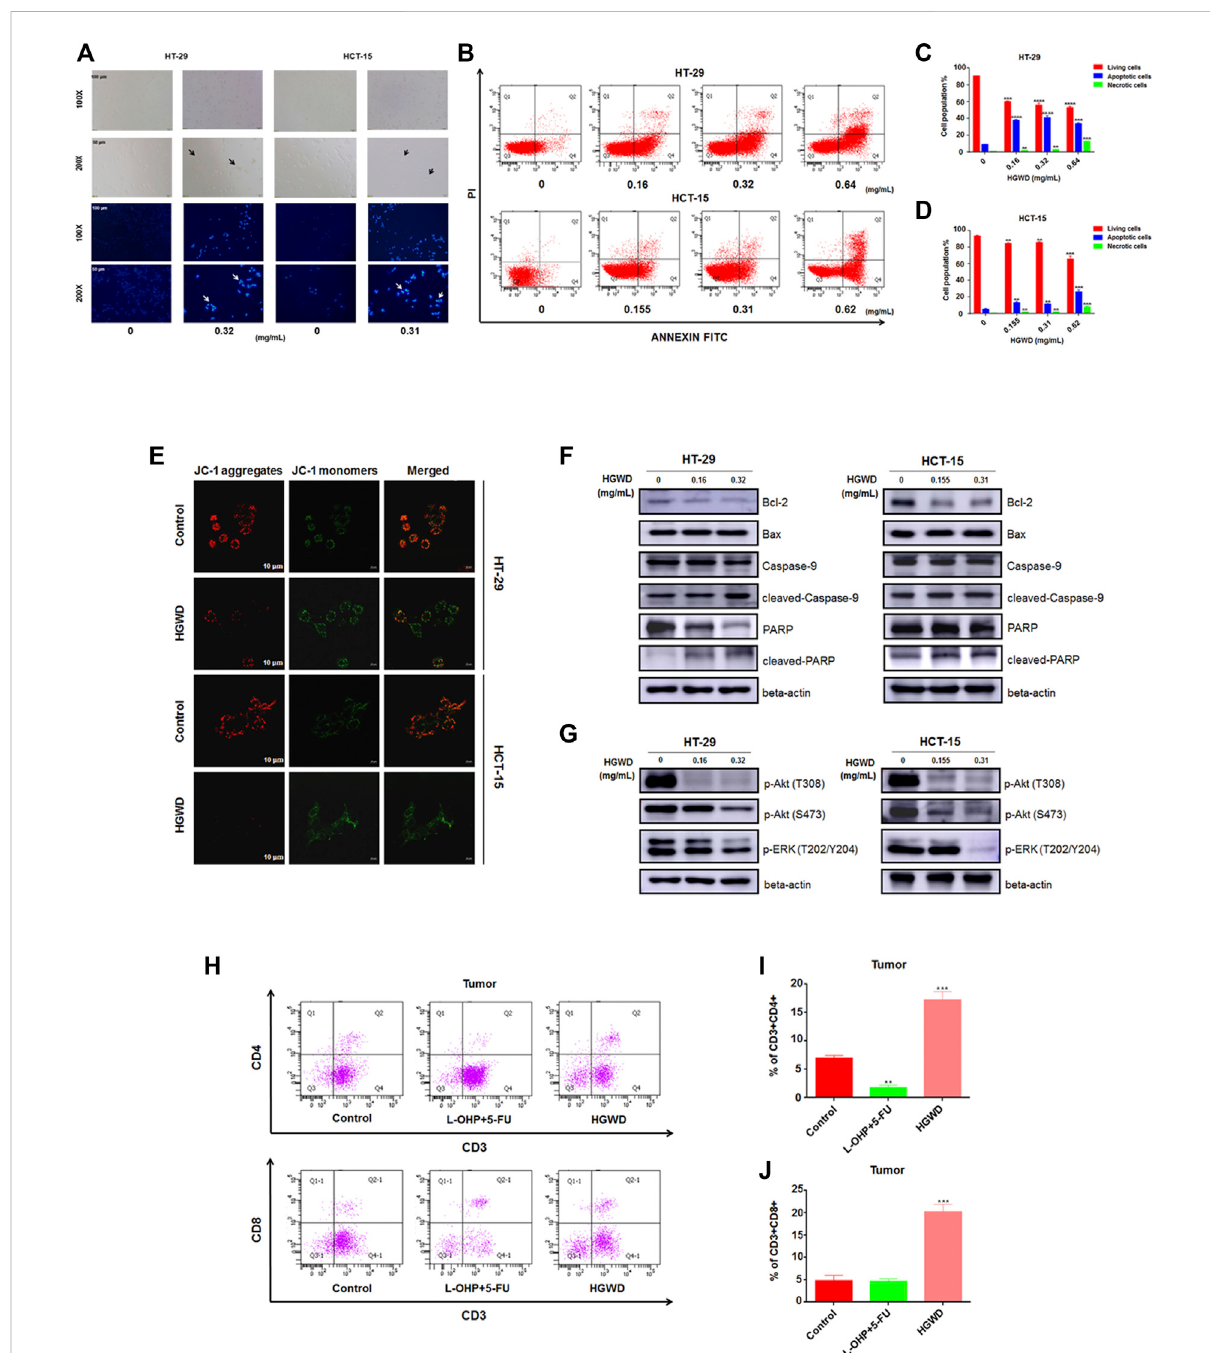
FIGURE 5 HGWD treatment enhanced apoptosis and down-regulated the levels of phosphorylation proteins in CC cell Akt and ERK signaling pathways. (A) CCcellsmorphologieswereevaluatedinwhitelightand fl uorescence fi eldbyinvertedmicroscopy. (B) Induction ofHT-29aswellasHCT-15cell apoptosis after HGWD treatment for 24 h.Apoptotic processes wereevaluated by fl ow cytometry. (C,D) Statistical assessmentsof theabundanceof apoptotic cells in HT-29 and HCT-15 cells. ** p < 0.01, *** p < 0.001 and **** p < 0.0001 (E) The mitochondrial membrane potential (MMP) decreasedofHT-29aswellasHCT-15cells24 hafterHGWDtreatment (F) HT-29aswellasHCT-15cellsweretreatedwithvariousHGWDdosesfor 24 h. After protein extraction, Bcl-2, pro-caspase-9, Bax, pro-PARP, cleaved-caspase-9, and cleaved-PARP levels were analyzed by WB, respectively. (G) HT-29aswellasHCT-15cellswereexposedtodifferentHGWDdosesfor24 h.Afterproteinextractions,p-Akt(T308),p-ERK(T202/ Y204) and p-Akt (S473) levels were respectively evaluated by WB (H) The abundance of the CD3 + CD4 + and CD3 + CD8 + T cells in xenografted CC tumors from different groups were detected by fl ow cytometry. (I,J) Statistical analyses of the abundance of the CD3 + CD4 + and CD3 + CD8 + T cells. ** p < 0.01 and *** p <